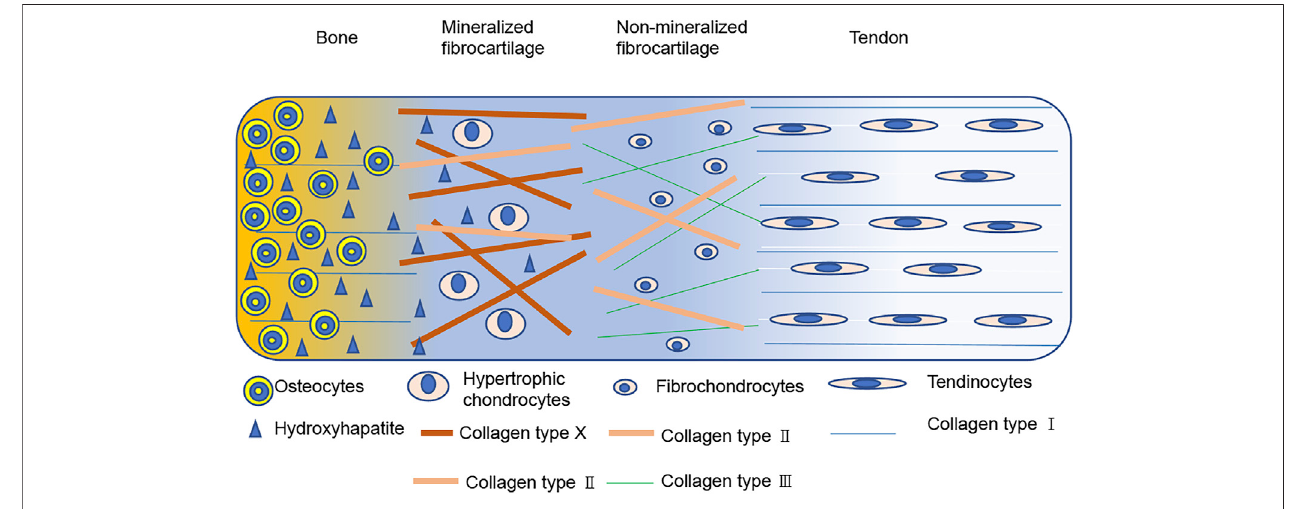
FIGURE 1 | Diagram of the four zones at the bone-tendon